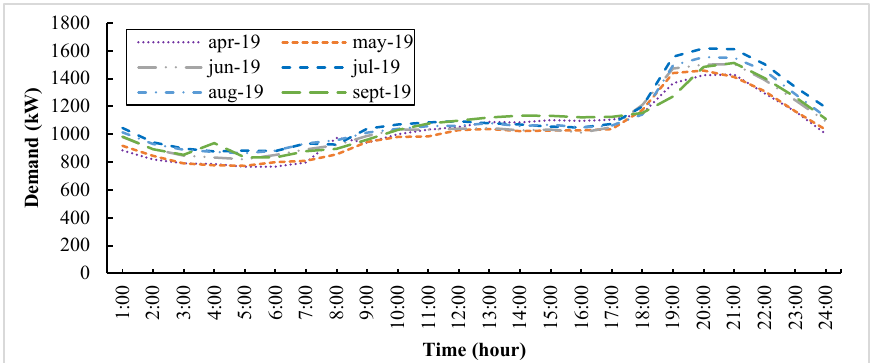
Figure 3. Average demand profile from April 2019 to September 2019.